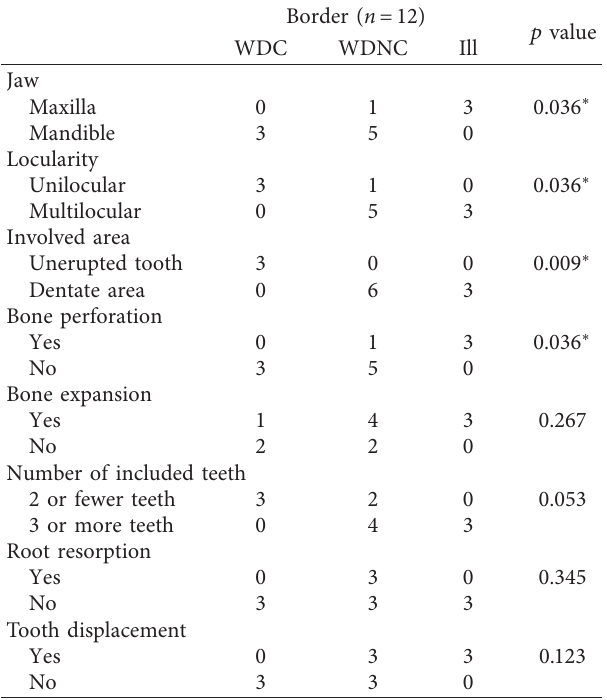
Table 3: Relationships of odontogenic myxoma borders with jaws, locularity, involved area, bone perforation, bone expansion, number of included teeth, root resorption, and tooth displacement.